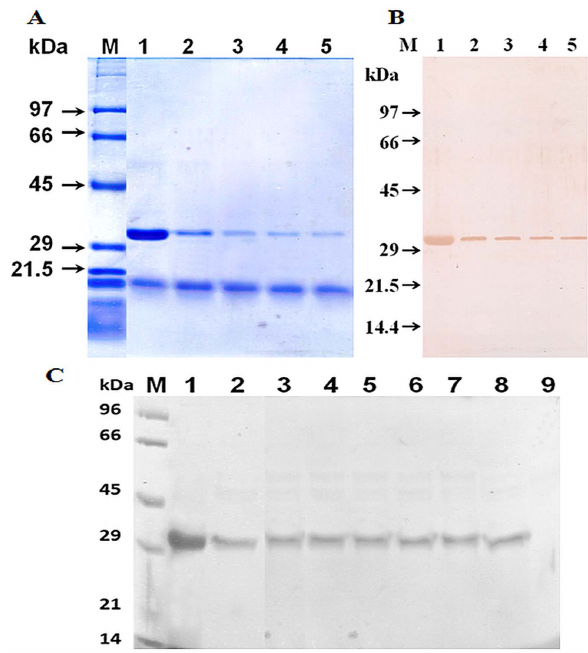
Figure 5. SDS-PAGE profile and immunoblot of 31 kDa kidney bean protein. Lane 1 : untreated, Lane 2 2 5 : boiled at 100 u C for 15, 30, 45 and 60 min, Lane M: molecular weight markers. Protein fractions were stained with Coomassie brilliant blue (A) and immunoblotted (B). SGF digestion of 31 kDa protein Lane M:molecular weight markers, Lane 1: 31 kDa protein (undigested), lanes 2 2 8: 31 kDa protein incubated in SGF for 0.5, 1, 5, 10, 15, 30 and 60 min, lane 9: pepsin. The digested protein was electrophoresed on SDS-PAGE and visualized by CBB staining (C).